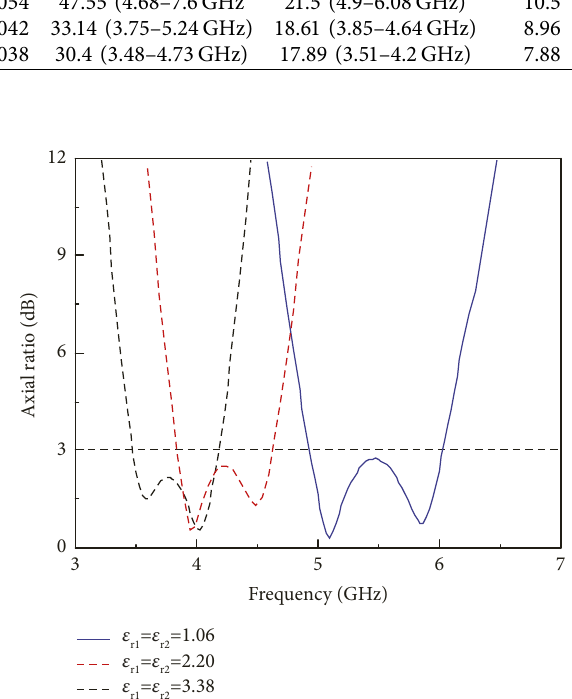
Figure 5: Effects of the substrate dielectric constant on the AR of the antenna.